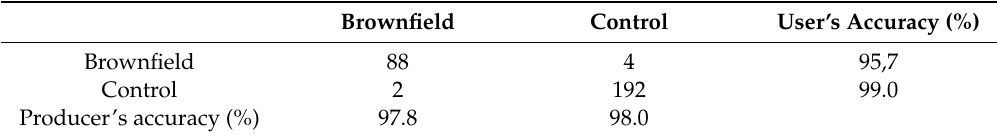
Table 3. Confusion matrix obtained from the regularized logistic regression (RLR) classification on the test set using the 14 vegetation indices. The brownfield class denotes the pixels from the 10 zones of the brownfield, and the control denotes those from the large control